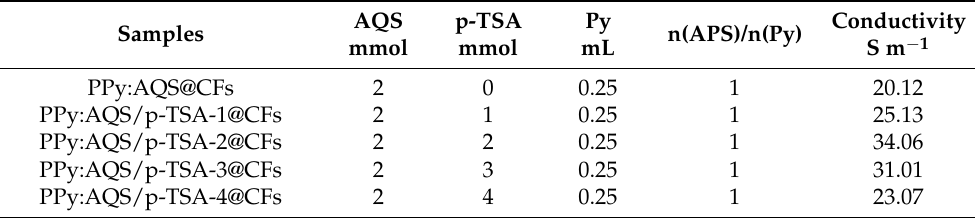
Table 1. Preparation conditions and conductivity of the PPy:AQS/p-TSA@CFs electrode materials.